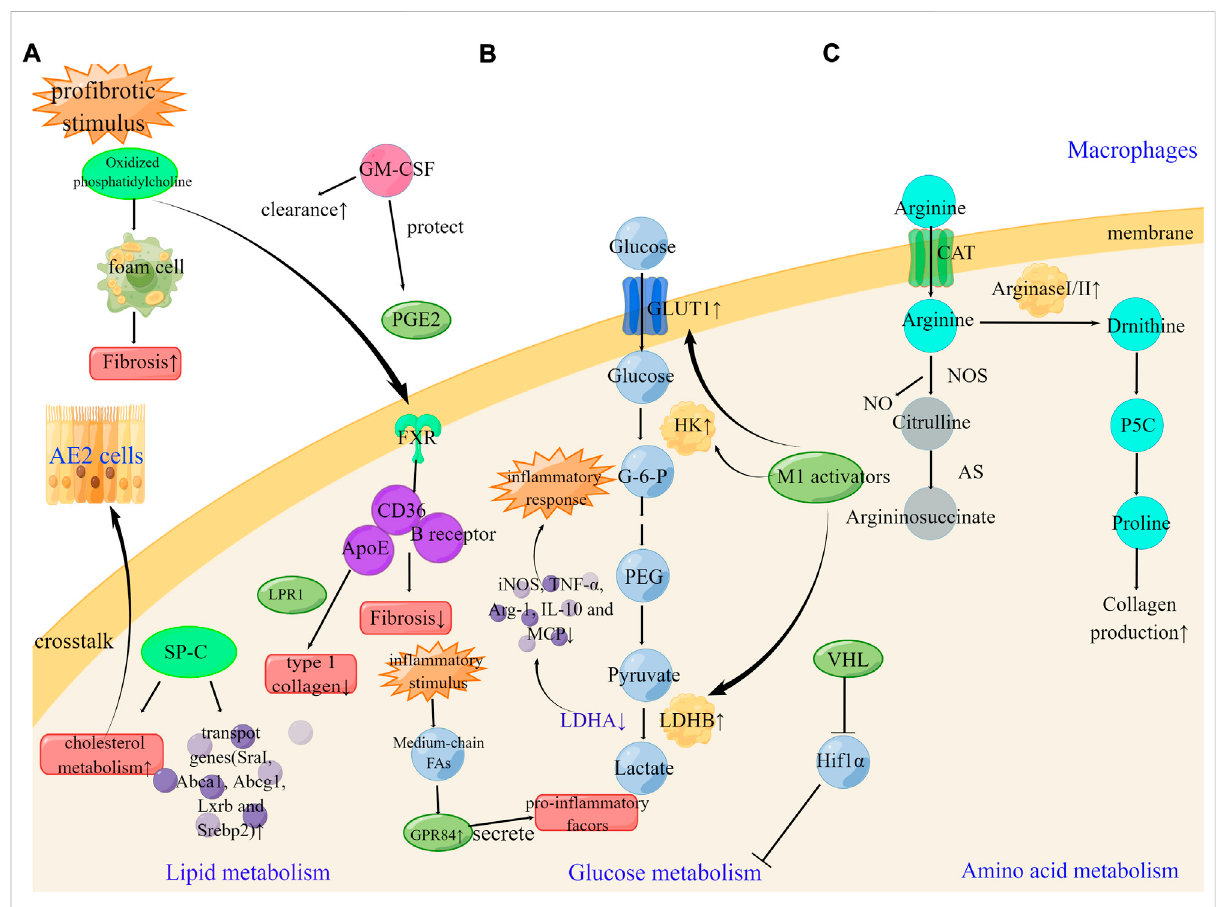
FIGURE 3 Metabolicreprogrammingofmacrophagescellsinpulmonary fi brosis (A) .GM-CSF,SP-C,andFXRcanenhancetheclearanceofoxidizedlipids and regulate lipid metabolism. The therapeutic targets FXR, ApoE and GPR84 can be effective in the development of pulmonary fi brosis (B) . Under pro fi brotic stimulus, M1 activators increase GLUT1, hexokinase, and LDHB leading to enhance glucose metabolism. Silencing of LDHA can suppress high levels of iNOS, TNF- α , Arg-1, IL-10, and MCP1. The therapeutic targets LDHA and VHL can be effective in the development of pulmonary fi brosis (C) . Arginase metabolism is partially dependent on the transport of arginine through CAT2 in peritoneal macrophages. The therapeutic targetsArginasecanbeeffectiveinthedevelopmentofpulmonary fi brosis.SP-C,surfactantproteinC;LPR1lipoproteinreceptor – relatedprotein1;B receptor; B class oxidized phospholipid scavenger